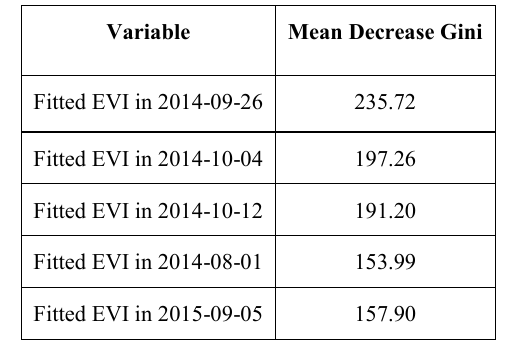
Table 2. Variable importance analysis results based on the